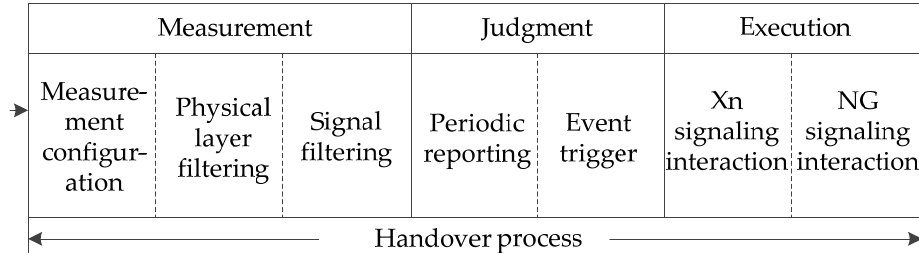
Figure 5. Diagram of the main process of the handover.